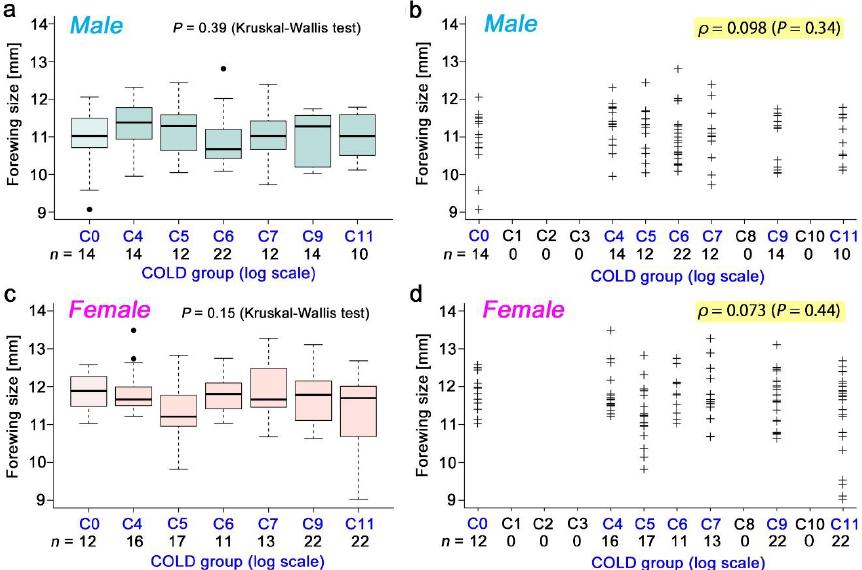
Figure 4. Forewing size of the individuals who consumed nonradioactive caesium chloride. In a and c, box plots were made, and the di ff erences among groups were examined using a Kruskal–Wallis test. In b and d, individual sample data were plotted, and a Spearman correlation analysis was performed. ( a , b ) Male forewing size. ( c , d ) Female forewing